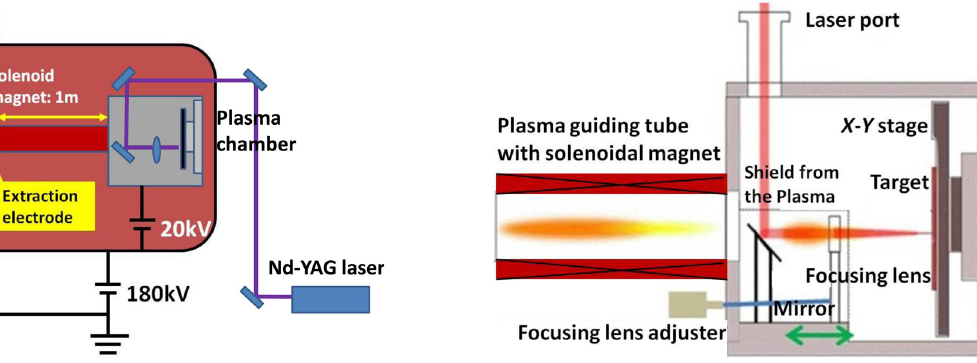
FIG. 2. The HVP for the LAIS system. FIG. 3. The LAIS irradiation